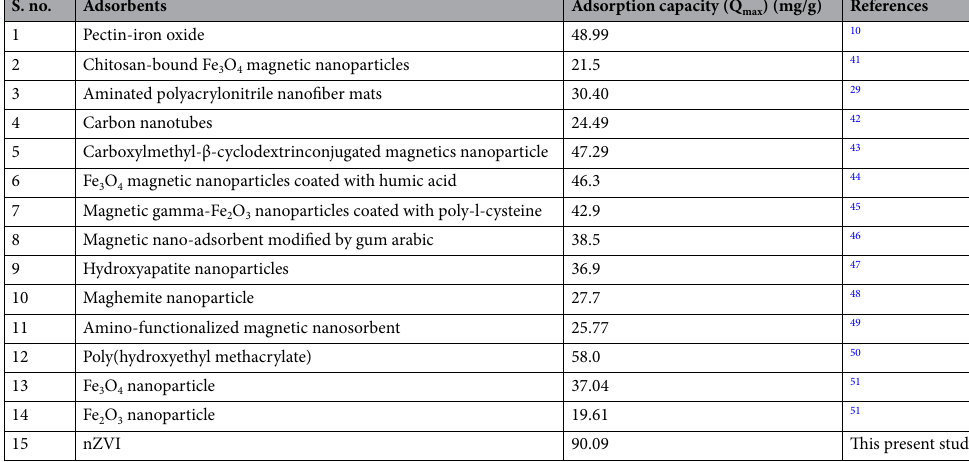
Table 4. Comparison of adsorption capacity nZVIf other nano-adsorbents used for Cu 2+ removal.